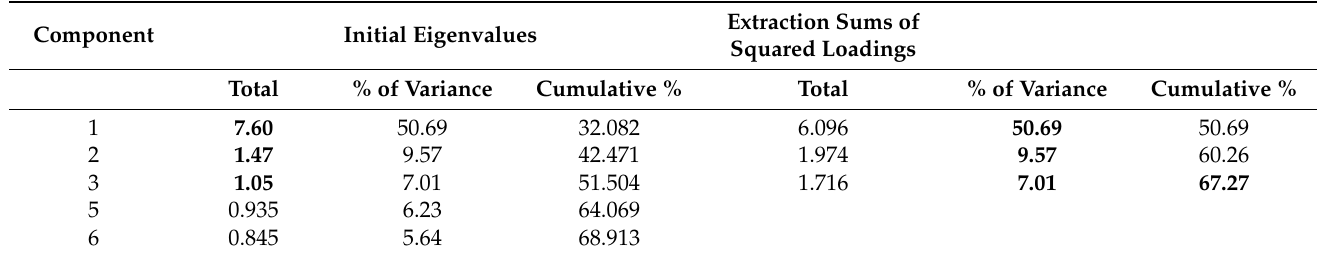
Table 4. Total Variance Explained.